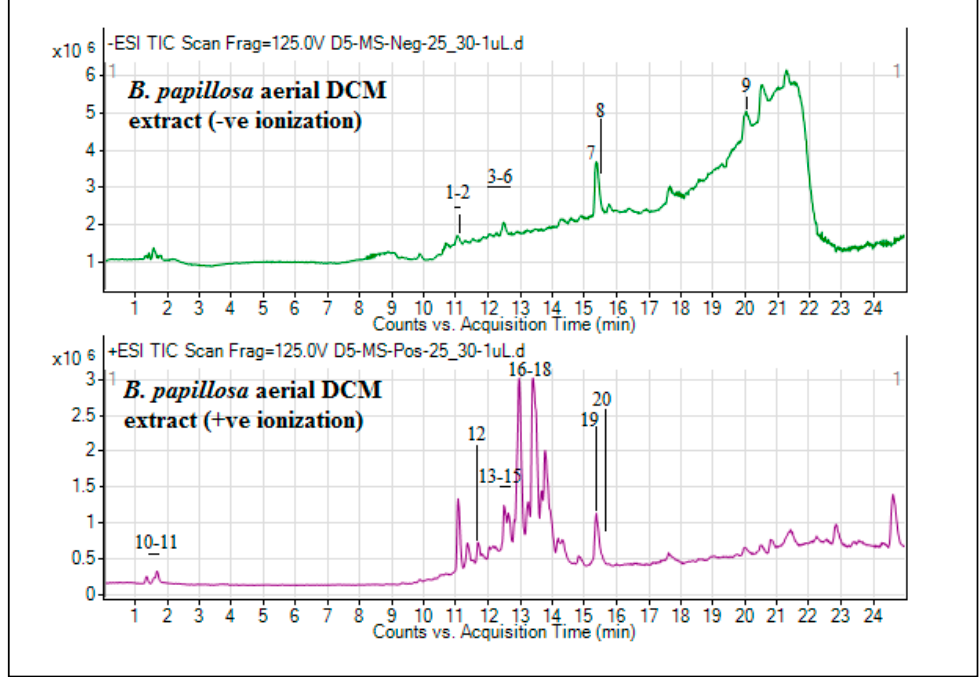
Figure 2. UHPLC-MS total ion chromatograms (TICs) of DCM extract of B. papillosa aerial parts.